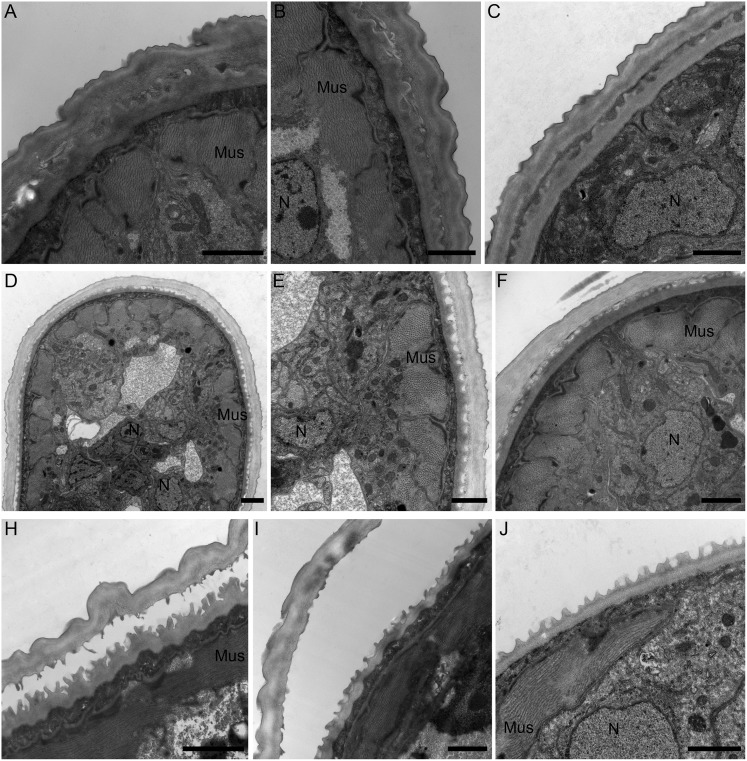
Transmission electron microscopy of OvL4 during molting to OvL5.A-C, Growth of new cuticle (c) beneath the old one (arrowheads) (day 48–50); D-F, beginning of cuticle separation (worms on day 50–60); H-J, final stage of cuticle separation (worms on days 60–75). Worms also had well-developed muscle filaments (Mus), and normal morphology of cells. Abbreviation: N—nuclei. Bar: A-C– 1 μm; D– 2 μm; E-J– 1 μm.